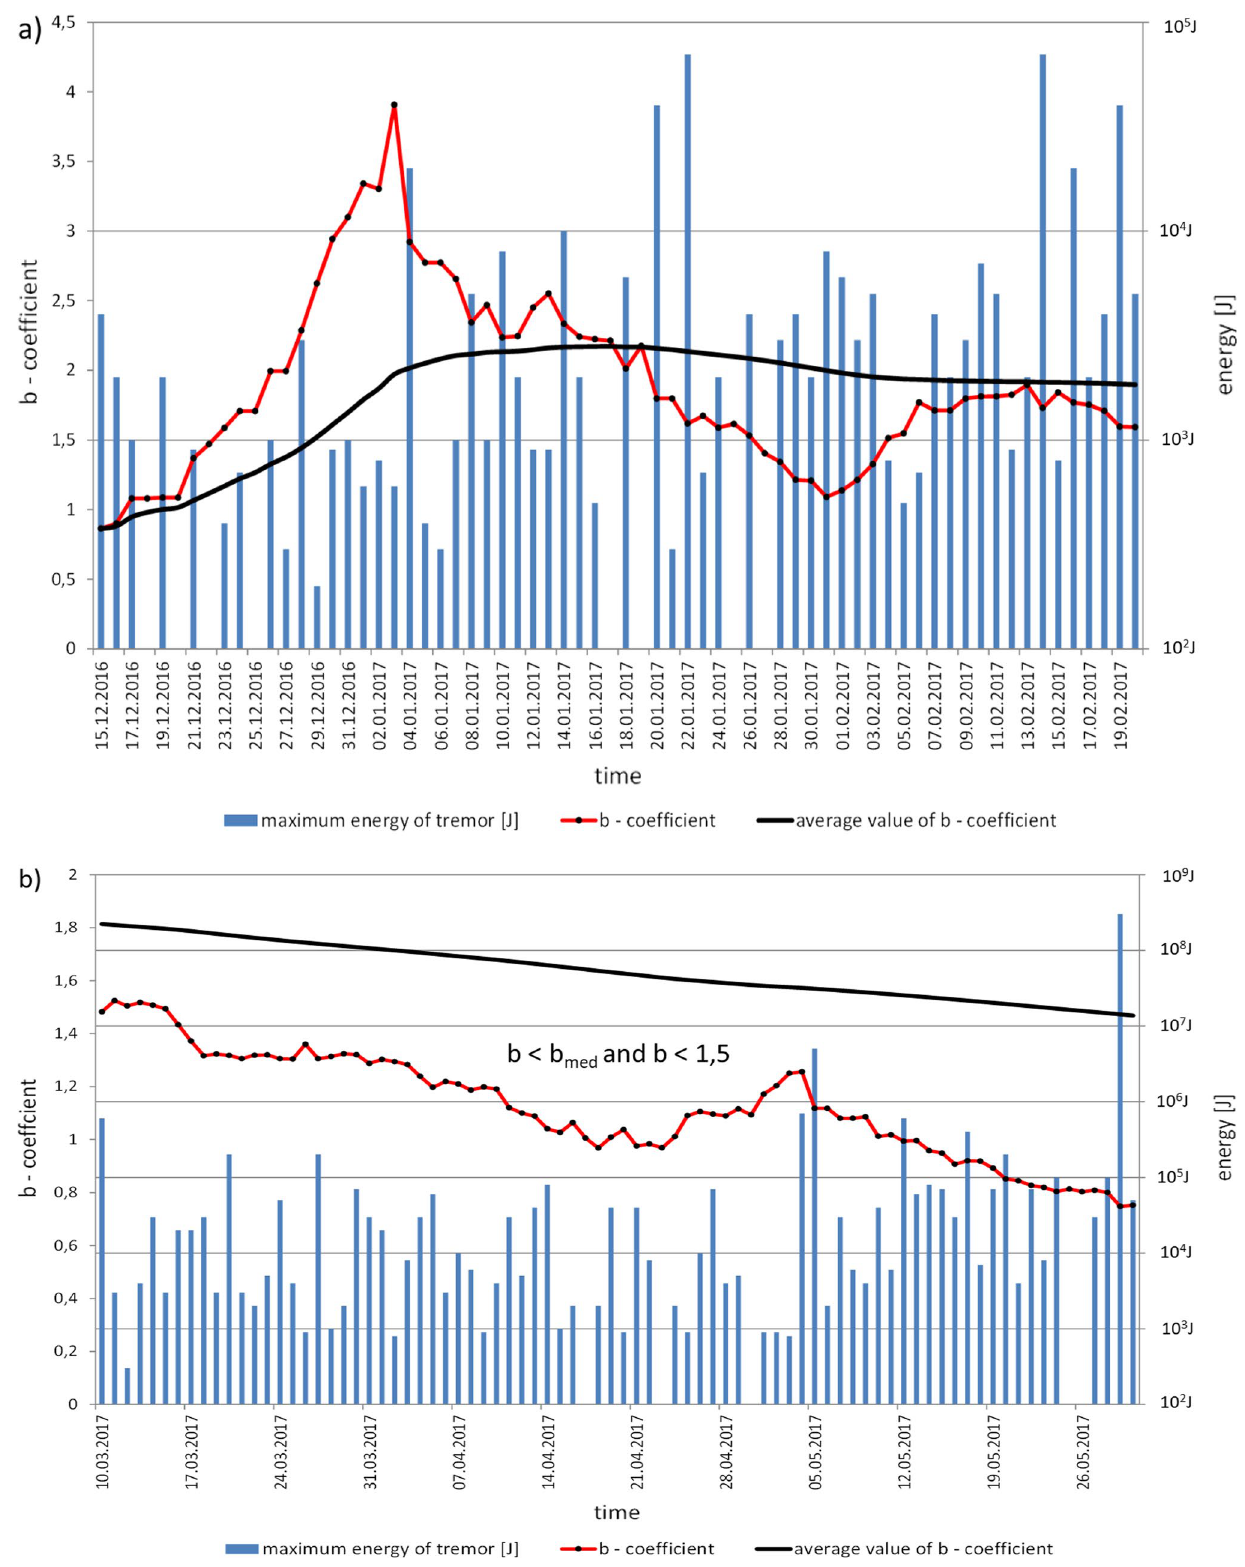
E max S along the longwall 02Aw panel in coal seam 510: a part I b part med parameters and